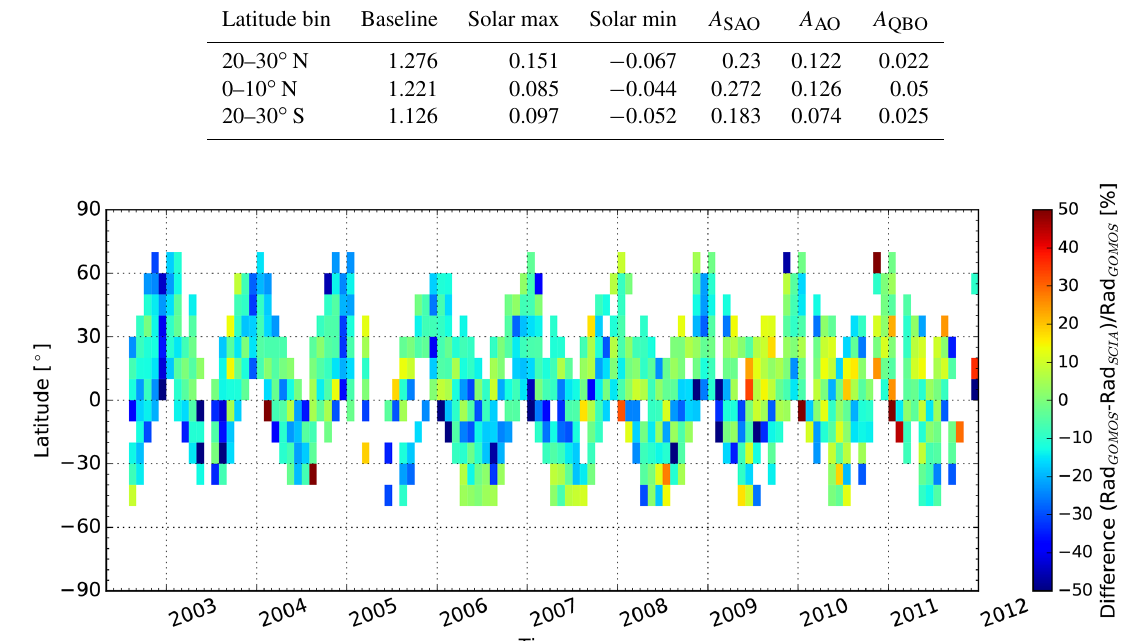
Figure 11. Temporal evolution of radiance differences (in percentage) between GOMOS and SCIAMACHY at a tangent altitude of 86.5km. The radiance is integrated over the wavelength of 930–935nm. Negative numbers indicate that SCIAMACHY radiances are larger than those of